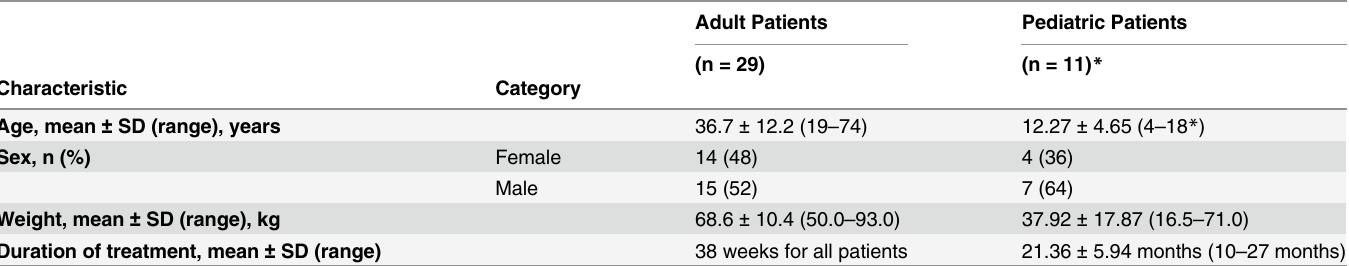
Table 1. Baseline demographics of adult and pediatric patients.